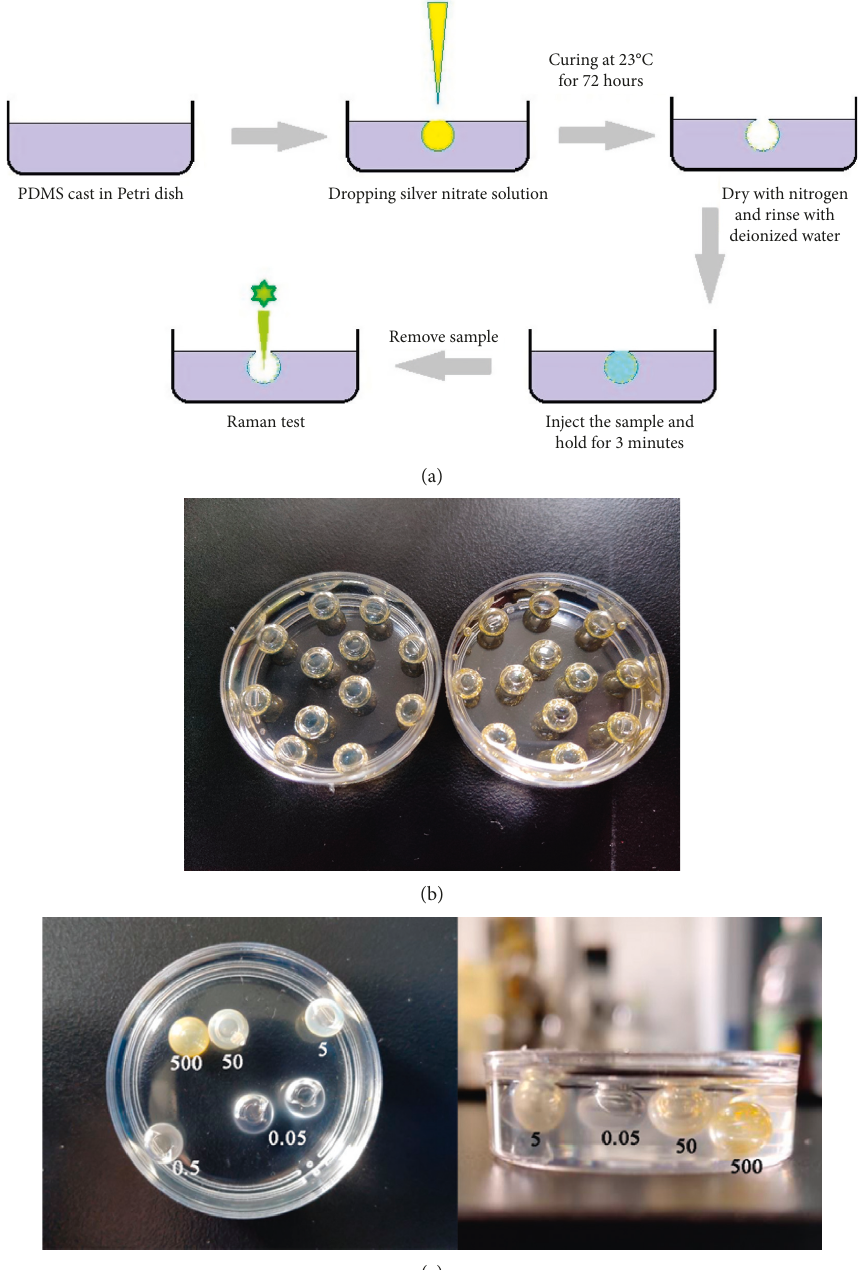
Figure 1: (a) Process of base fabrication; (b) PDMS plasma cavity is fabricated; (c) a schematic diagram of the position of the cavity formed by different concentrations of silver